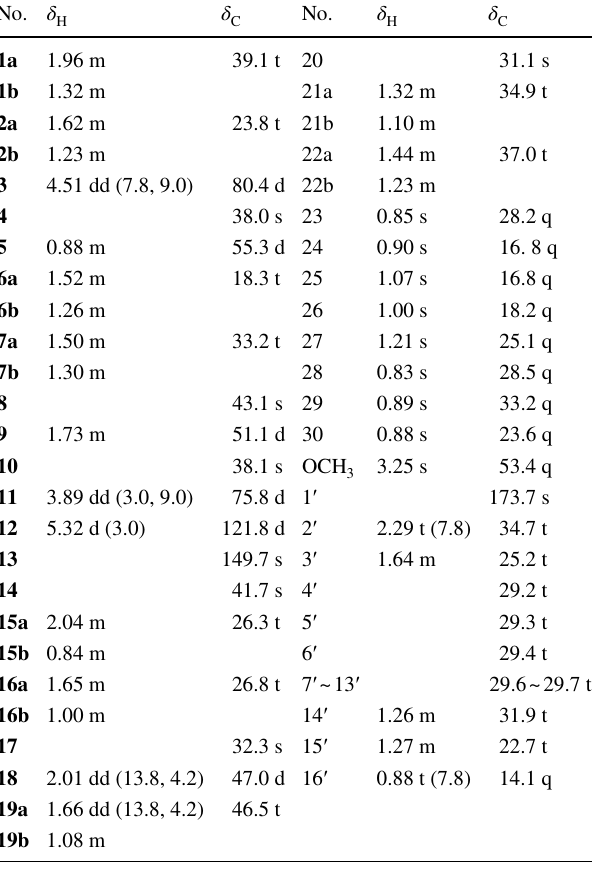
Table 2 1 H NMR (600 MHz, CDCl CDCl 3 ) data for compound 2